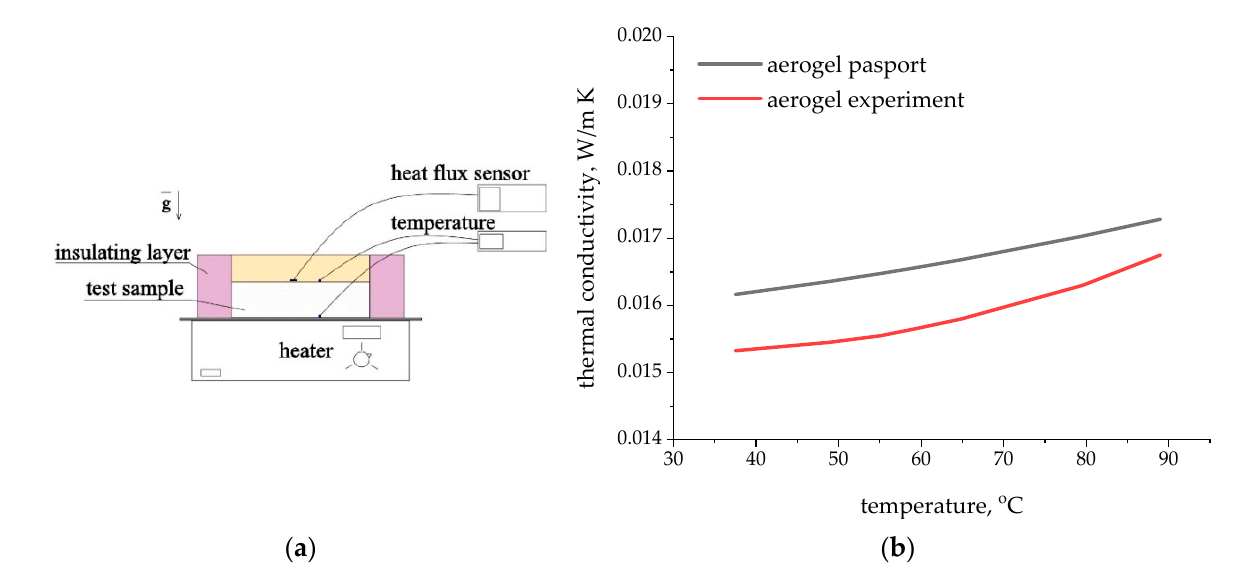
Figure 6. Laboratory measurements of aerogel thermal conductivity: ( a ) experimental setup; ( b ) thermal conductivity. mal